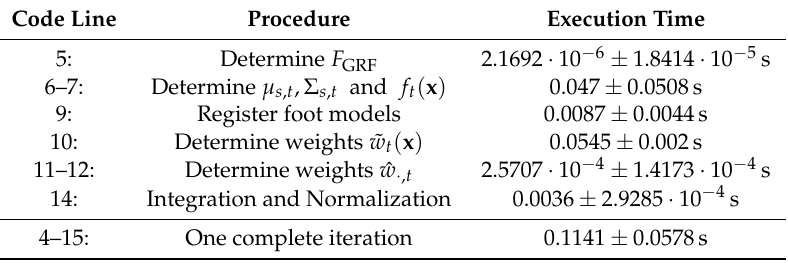
Table 2. Execution times regarding one full iteration (last line) and the substeps during a sway all around measurement. The third column shows the mean values and one standard deviation of the required time for 1308